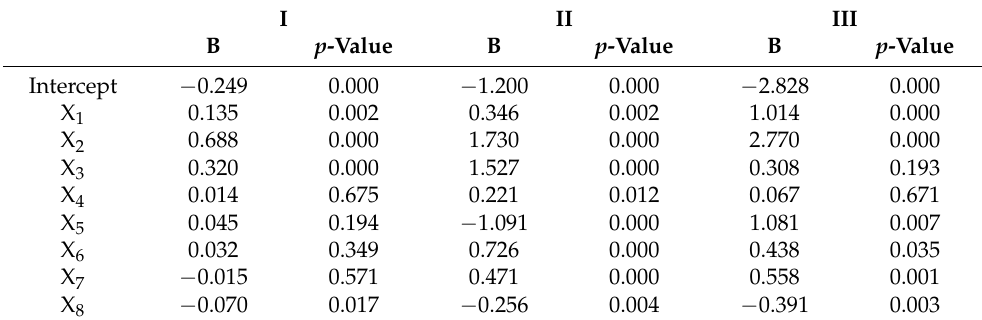
Table 2. Preliminary MLR Model.